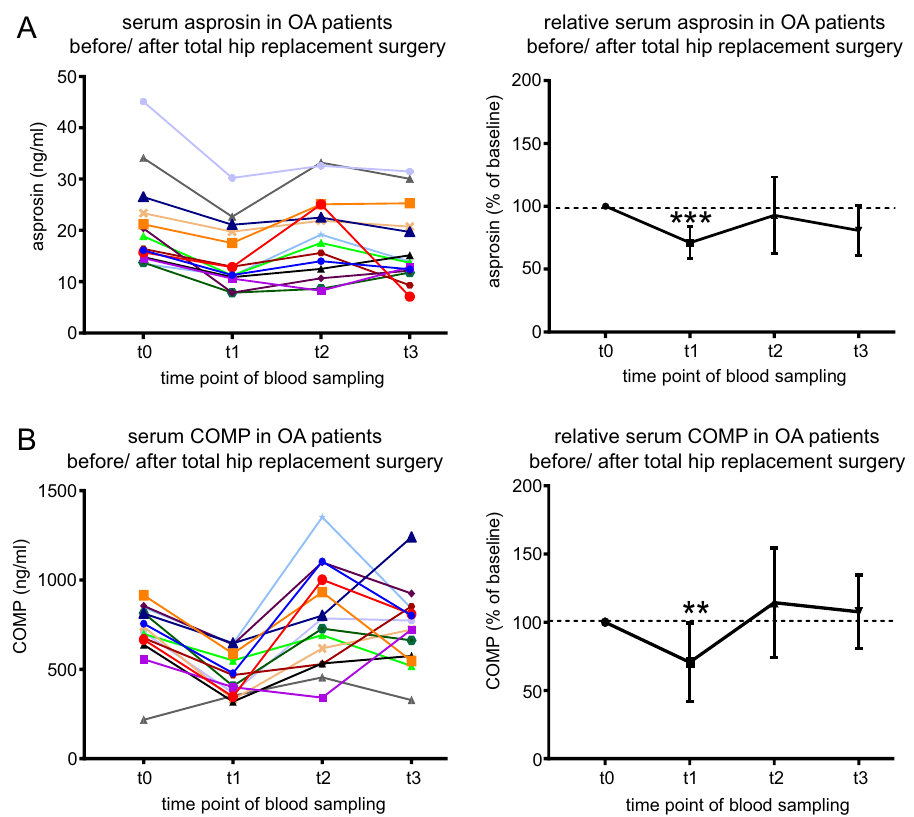
Figure 6. Asprosin levels in serum correlate with the cartilage marker COMP upon hip replacement surgery. ( A ) (left) Absolute serum asprosin (ng/ml) for each patient before and until one year after total hip replacement (THR). (right) Relative asprosin concentration after THR (t1, t2, and t3) normalized to serum asprosin at baseline (t0, before THR). ( B ) (left) Absolute serum COMP (ng/ml) for each patient before and until one year after THR. (right) Relative serum COMP (%) after THR (t1, t2, and t3) normalized to serum COMP at baseline (t0, before THR). n = 14 patients; time points: t0: within 1 week before THR, t1: 7 days postoperative, t2: 3 months postoperative, t3: about 1 year postoperative. *** P = 0.0003, ** P = 0.0056. Serum (25 µl) fourfold diluted in PBS (75 µl) for asprosin concentration analysis, and 2 µl serum 50-fold diluted in 98 µl PBS for COMP concentration analysis. Data were analyzed using Graphpad Prism version